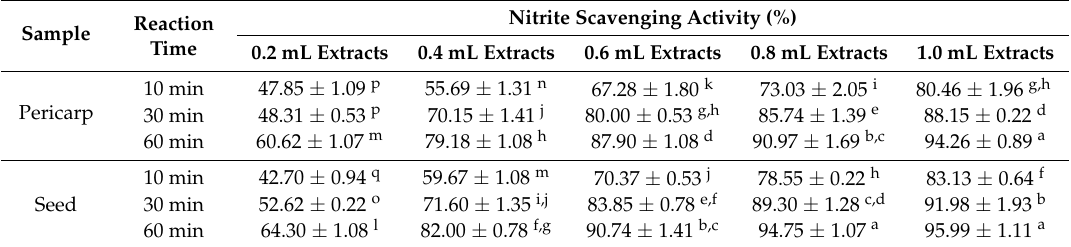
Table 4. Nitrite scavenging activities of phenolic extracts from longan byproducts.